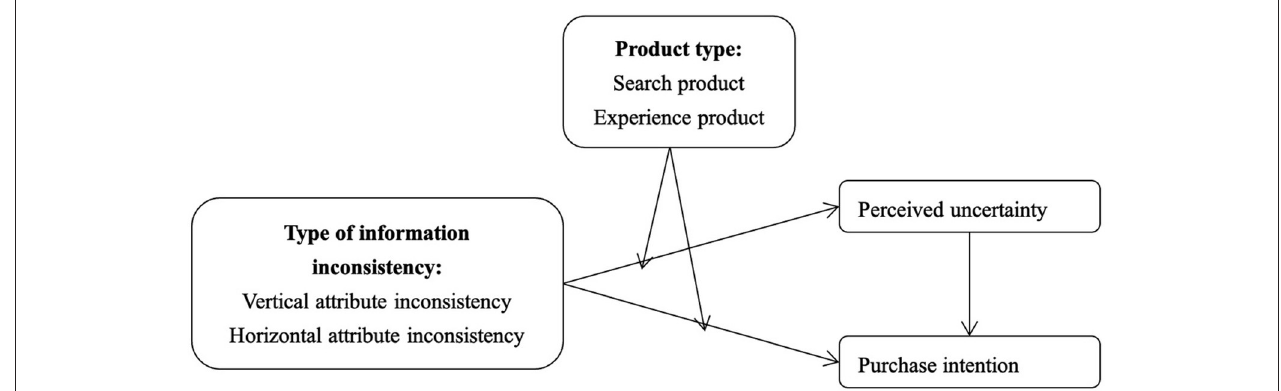
FIGURE 1 | Conceptual